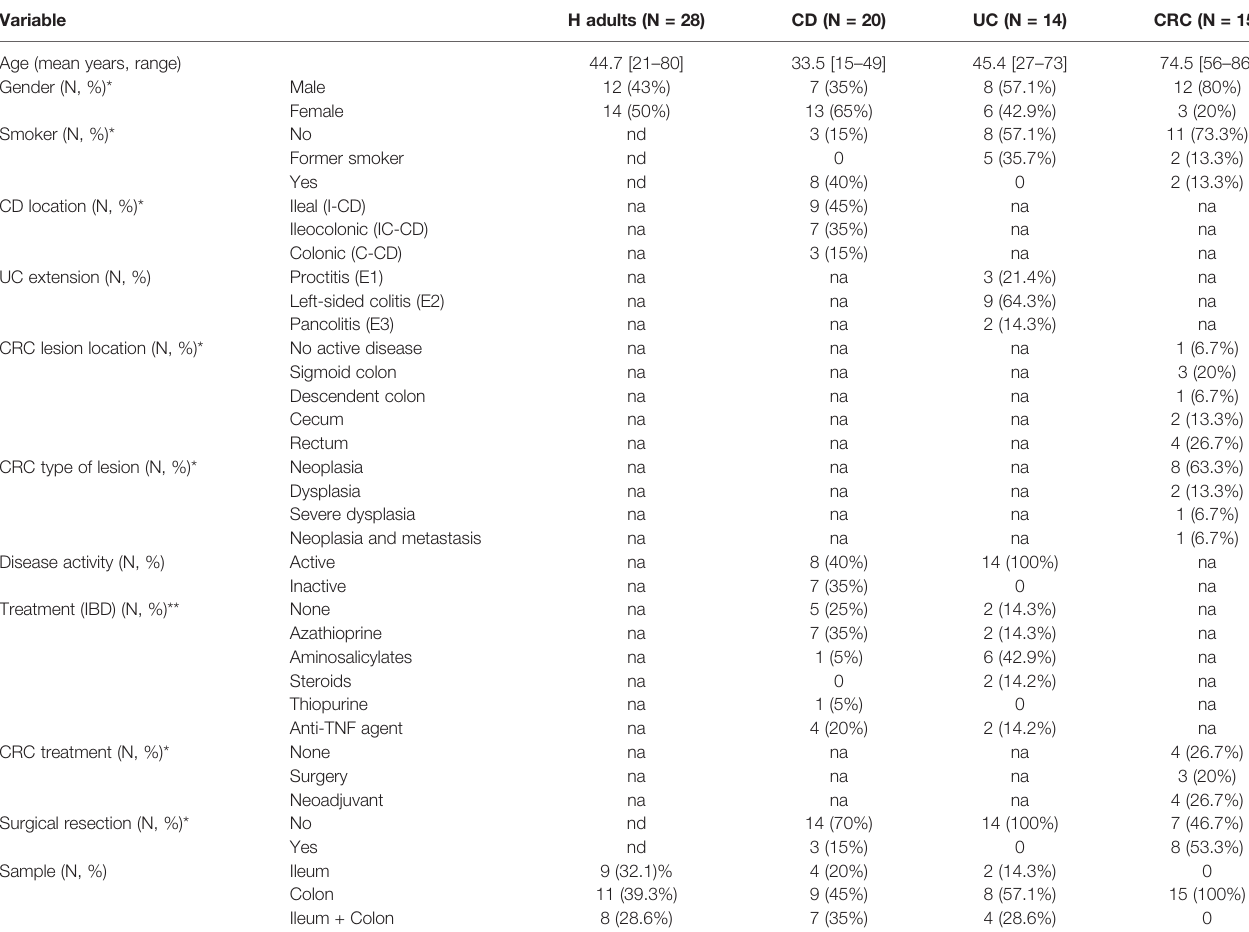
TABLE 1 | Characteristics of adult study